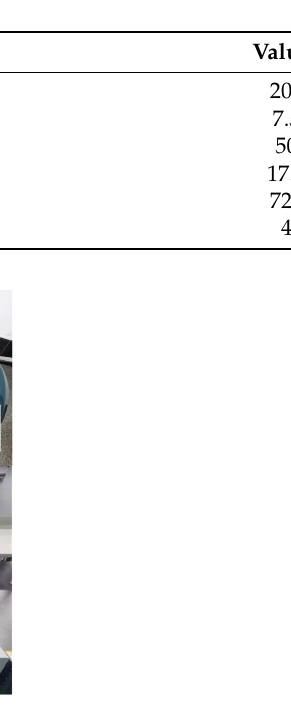
Figure 9. The prototype of dSPACE ® DS1007 driven three-level inverter.